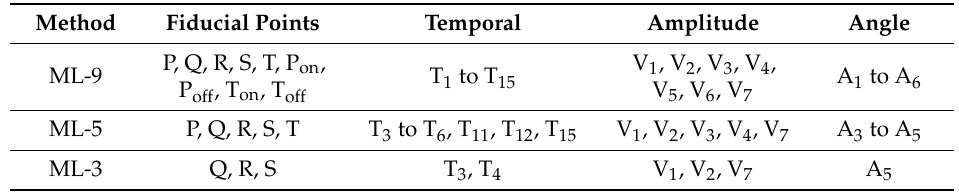
Figure 6. Feature extraction based on fiducial points. Table 2. Summary of extracted fiducial features. ML: machine learning; ML-N: using N fiducial points in ML.